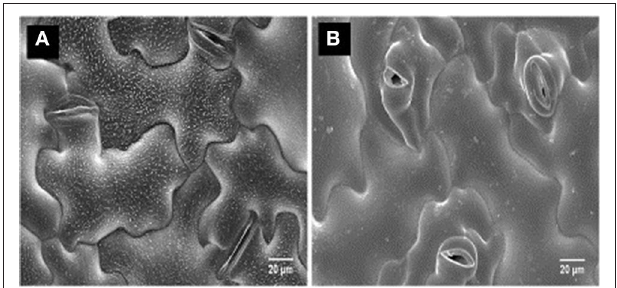
FIGURE 6 | CryoSEM of a susceptible vs. a resistant genotype of Brassica carinata , after a challenge inoculation of the cotyledons with Neopseudocercosporella capsellae : highly resistant B. carinata genotype ATC94129P (A) , highly susceptible B. carinata genotype UWA#012 (B)